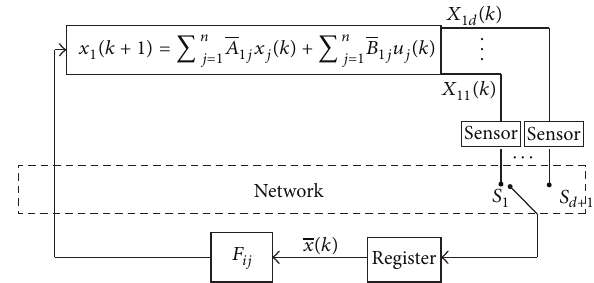
Figure 2: The structure of an NCS with S/C channel.